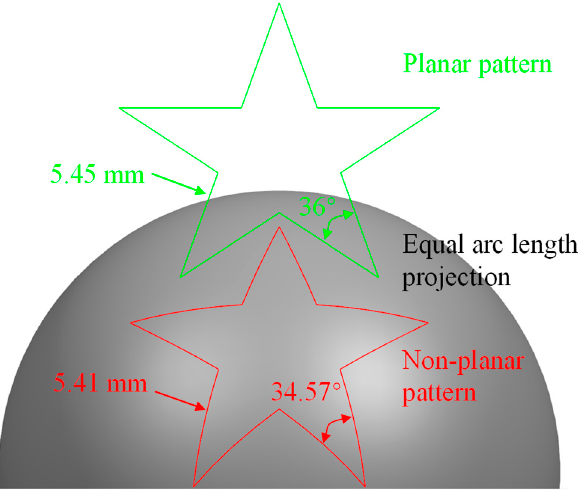
Figure 6. Geometrical parameters of planar pentagonal pattern and projected non-planar pentagonal pattern onto spherical surface. pattern onto spherical